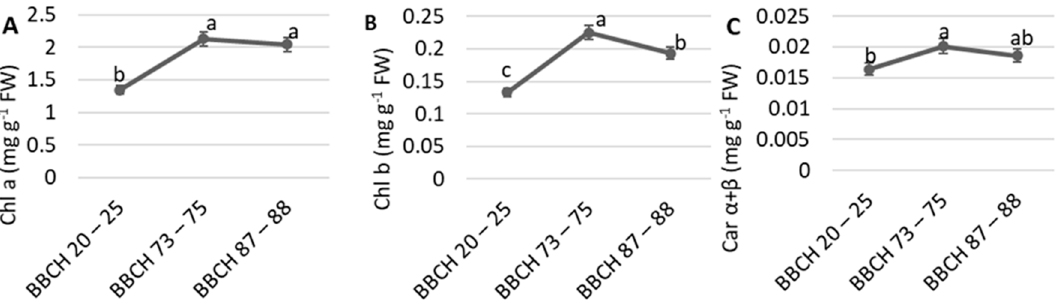
Figure 4. E ff ect of seasonality on the accumulation of chlorophyll a ( A ), chlorophyll b ( B ) carotenes α and β ( C ). The di ff erent letters in graphics indicate significant di ff erences. The data presented as an average of four planting distances. The data were processed using analysis of variance (Anova), the Turkey (HSD) test at the confidence level p = 0.05.